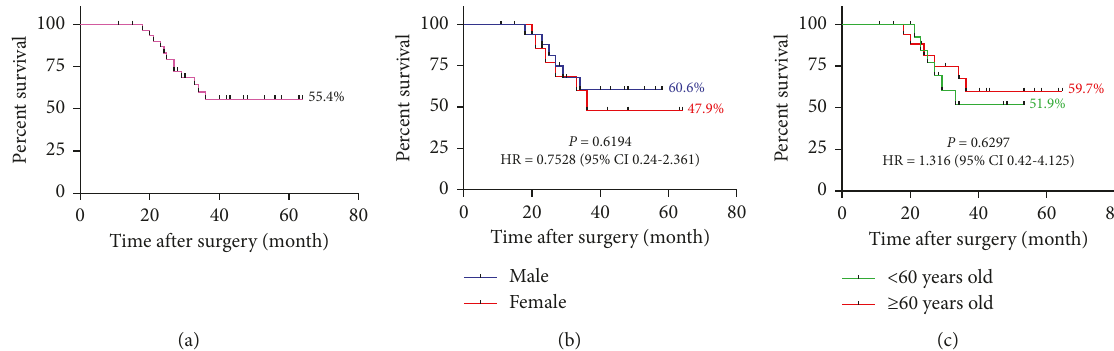
Figure 1: Survival analysis of 33 patients undergoing resection of pulmonary metastases. (a) Kaplan–Meier curve of the overall survival rate; comparison of overall survival between the different sex groups (b) and age groups (c) by Kaplan–Meier curves. Genetic characteristics of the primary tumor and pulmonary